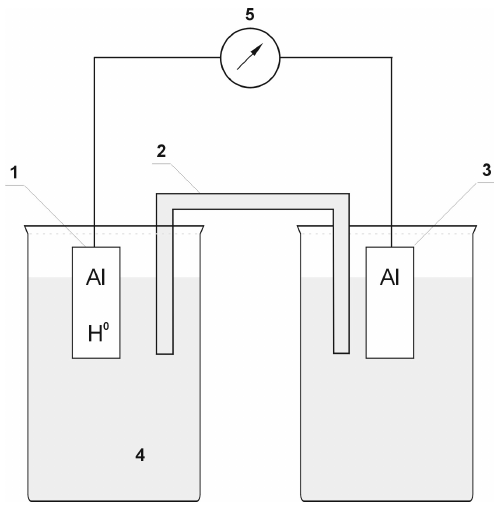
Figure 5. Galvanic cell for measuring the variations in electromotive force (EMF) after hydrogenation (or after removing passive layers). 1: hydrogenated (or without passive layers) sample of alloy, 2: salt bridge, 3: non hydrogenated (or with passive layers) sample of alloy, 4: electrolyte, 5: multimeter/potentiostat. Figure 6 contains details of the measurement plan: preparation and measuring setup and the order of measurements.